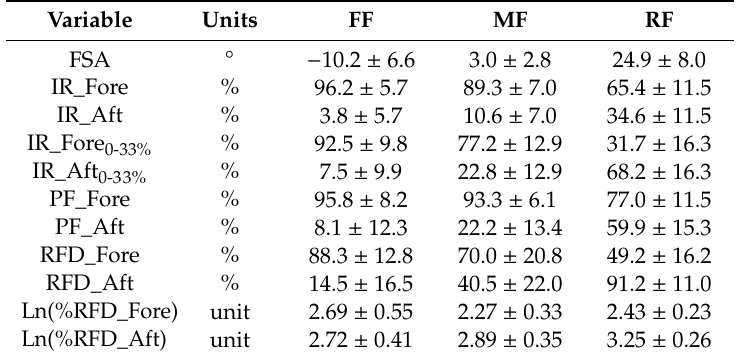
Table 2. Descriptive statistics (mean ± standard deviation) are presented for each variable used in model development, grouped by FSP (classified by measured kinematic